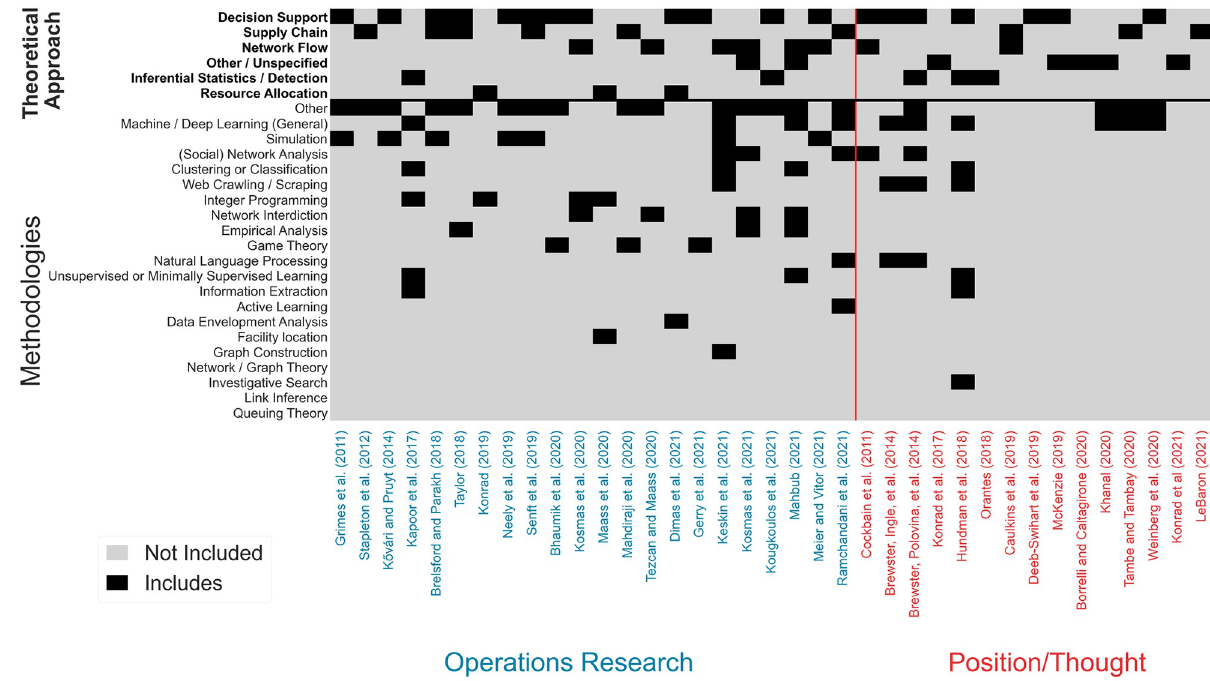
Fig 8. Granular view of theoretical and methodological topic inclusion for the set of studies categorized as operations research or position / thought. The x -axis lists each study; and the y -axis depicts each of the Theoretical Approaches and Method. Operations Research studies appear on the left (in blue), and Position / Thought studies appear on the right (in red). If a study includes a given feature value, the box is black, and grey otherwise. Theoretical approaches and methods are sorted in descending order based on the total count for each row.